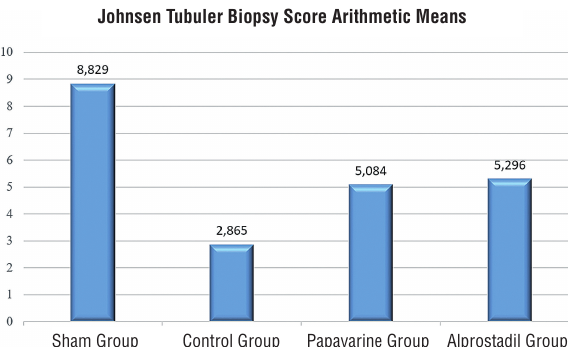
Sham Group Control